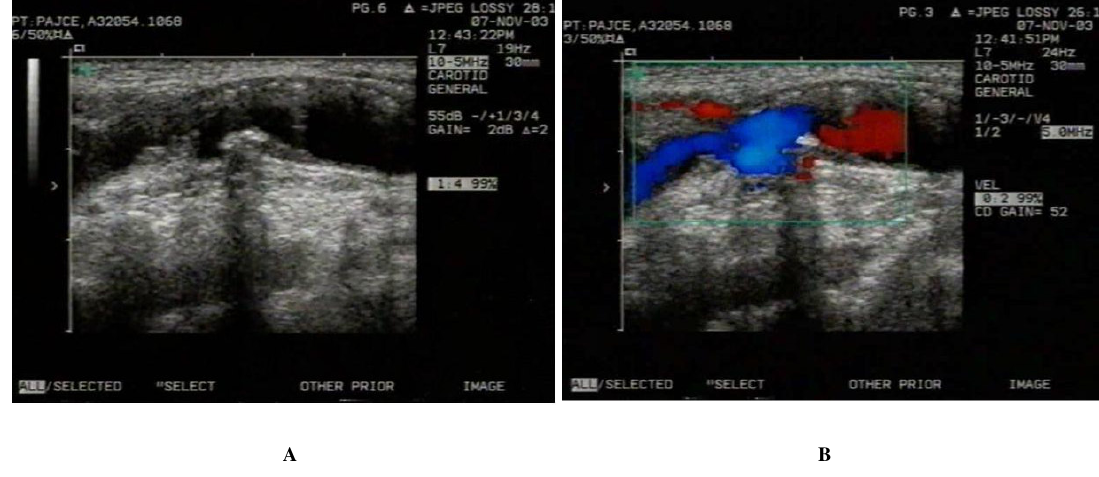
FIGURE 1 . Ulcerated plaque with big embolic potential (A). Color inflow inside of the plaque (B).